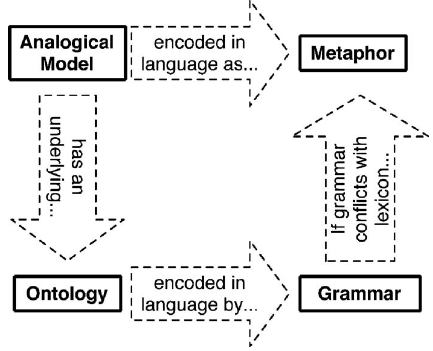
FIG. 2. Summary of the roles of analogy, metaphor, ontology,